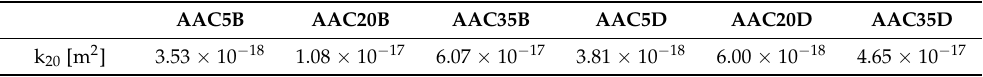
Table 2. The intrinsic permeability values for specimens preconditioned at 20 °C.